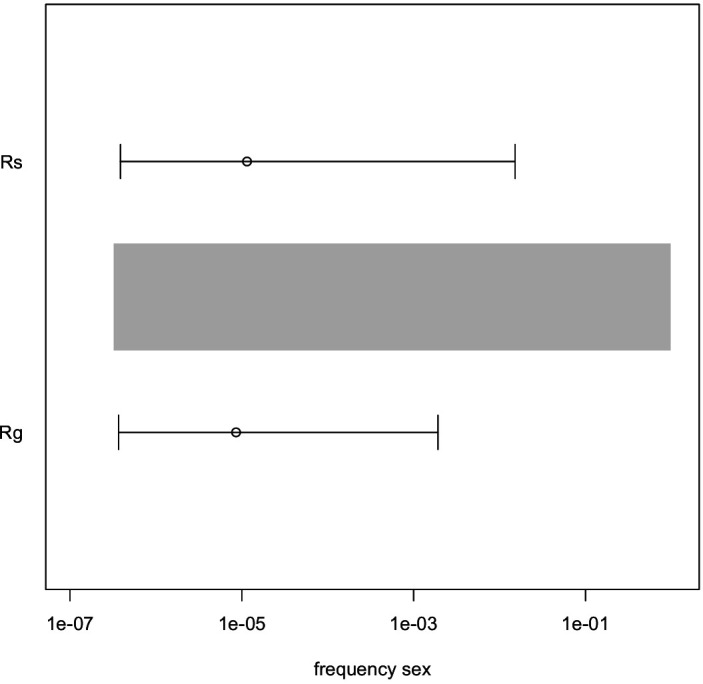
The median and 95% Highest Posterior Density interval of the frequency of sexual recombination affecting the presence/absence of LTR polymorphisms in R. magnacalcarata and R. socialis.The grey bar shows the prior distribution used in simulations for the Approximate Bayesian Computation analysis. Confidence limits are broad but encompass the lowest range of the prior and hence cannot reject the hypothesis that recombination is absent for these loci.